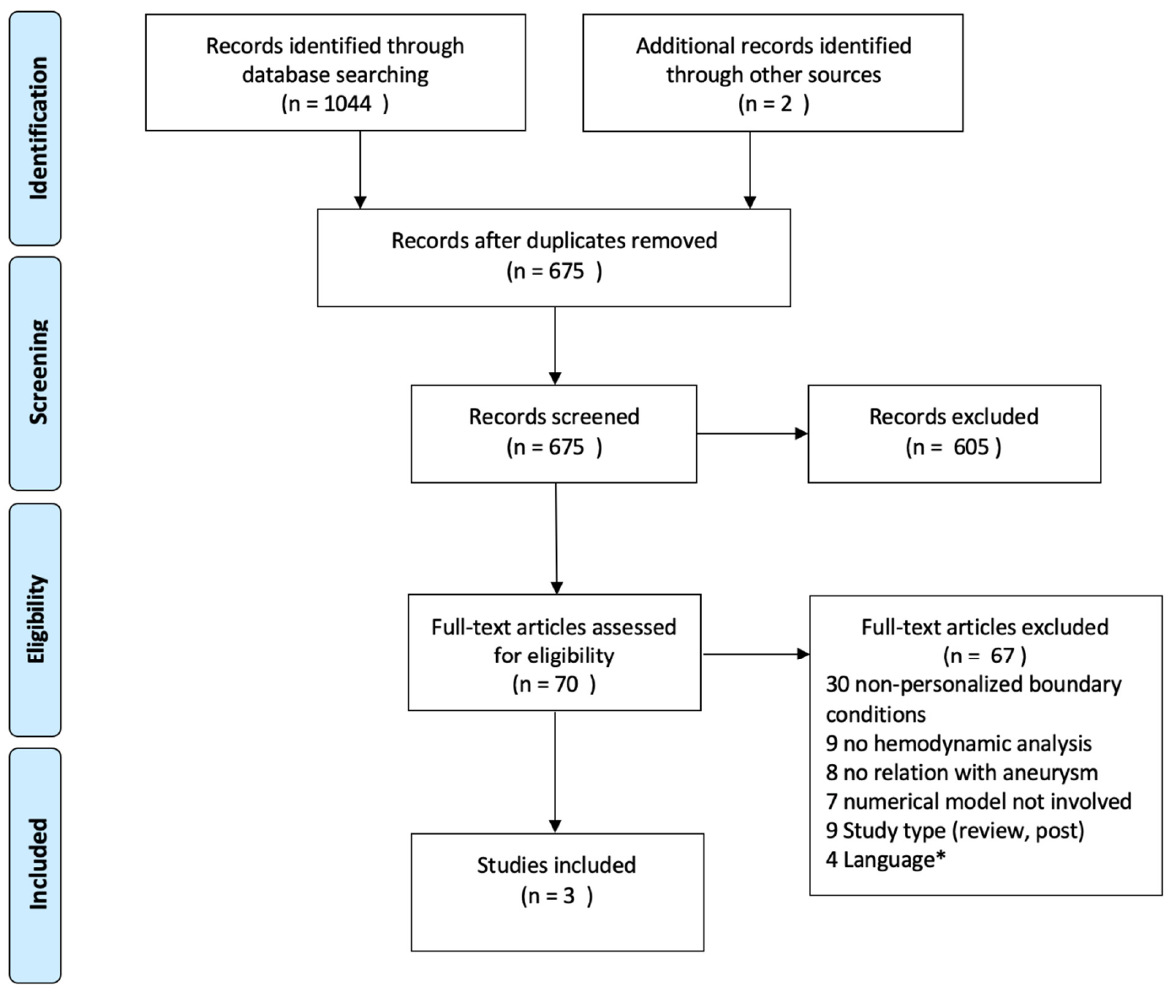
Figure 2. PRISMA Flow Diagram. * List in Supplementary S2.